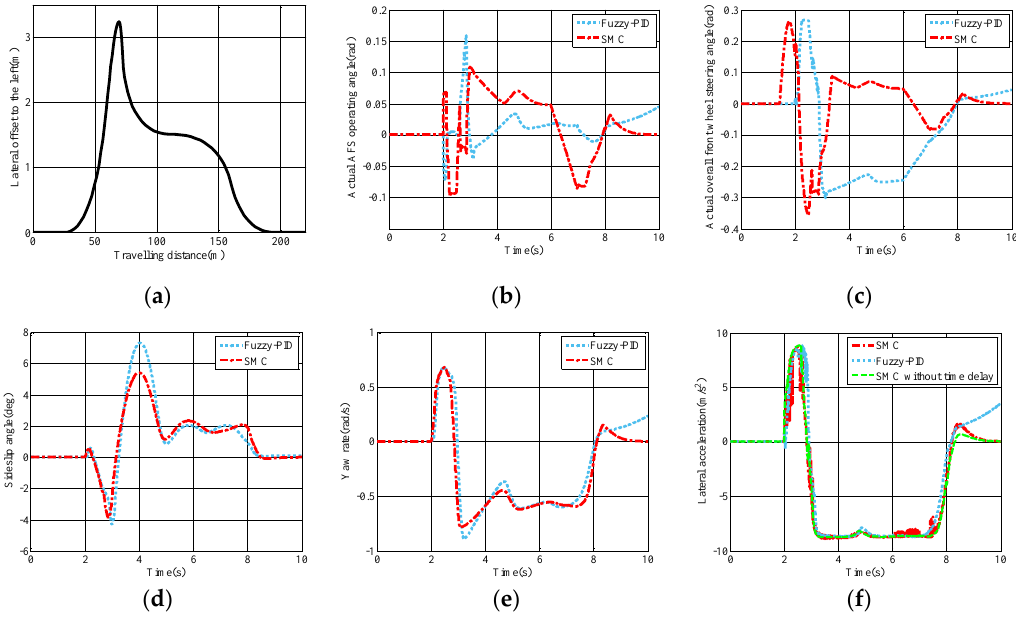
Figure 11. Simulation results of accident avoidance test: ( a ) Lateral offset to the left; ( b ) actual AFS operating angle; ( c ) actual overall front wheel steering angle; ( d ) sideslip angle; ( e ) yaw rate; and ( f ) lateral acceleration.